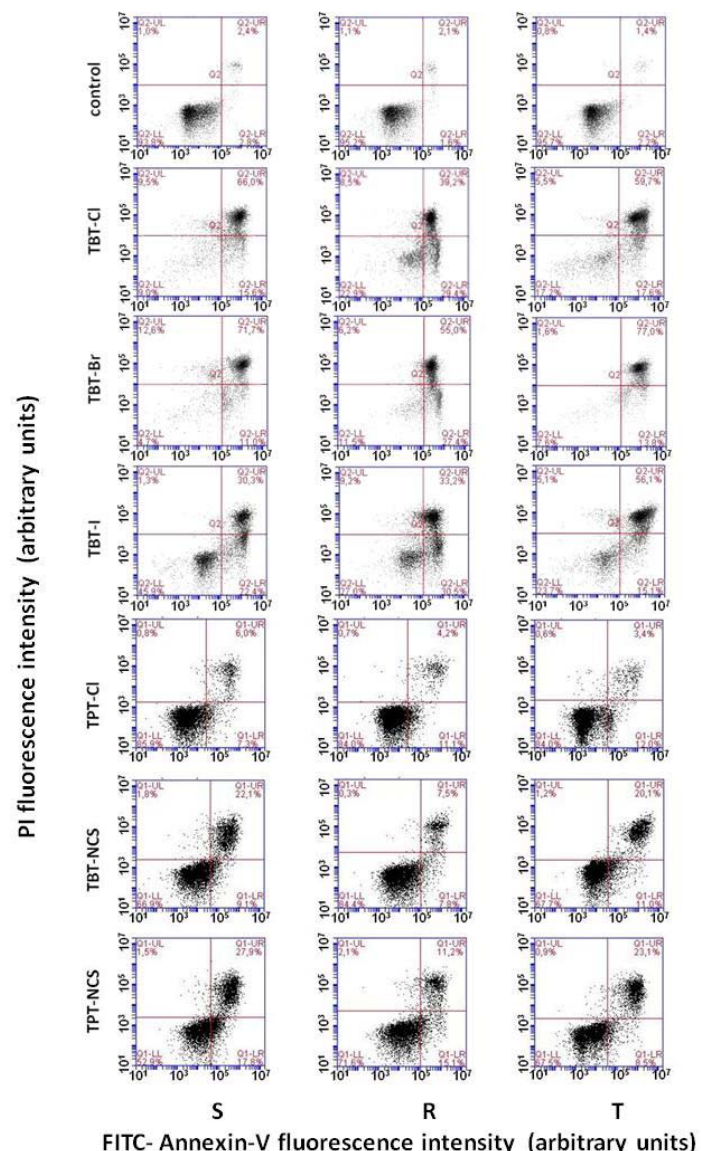
Figure 4. Measurement of S, R and T cells proportions in apoptosis and necrosis using a AV/PI apoptosis necrosis kit. The cells were cultivated for 24 h in cultivation medium in the absence or presence of triorganotin derivatives (0.2 µM) prior to this measurement. The dot blots are representative of three independent measurements.